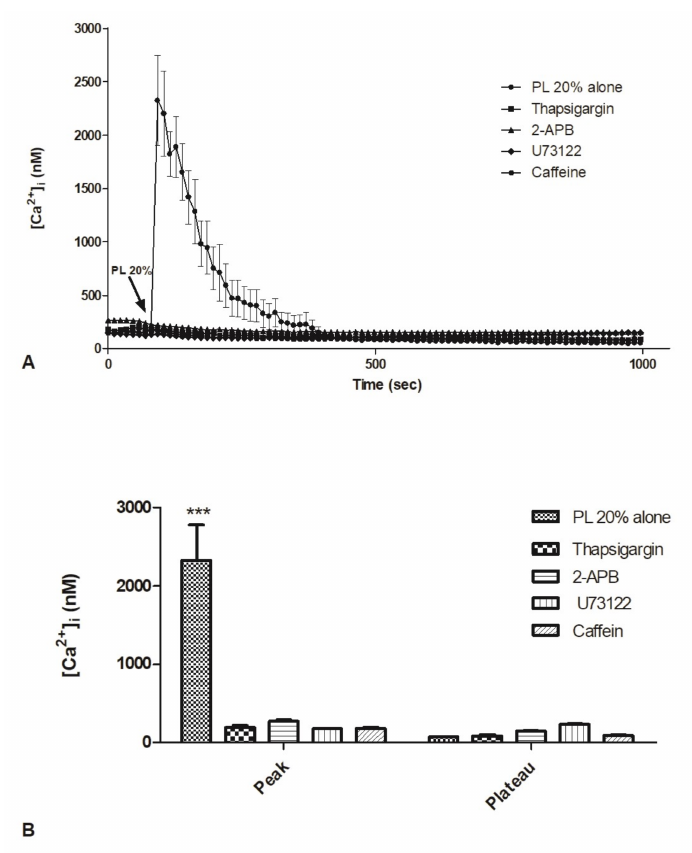
Figure 6. Contribution of intracellular stores to cytosolic Ca 2 + increase. A . PL-induced Ca 2 + release was dramatically reduced in the presence of thapsigargin, 2-APB, U73122, ca ff eine (30 min pre-incubation for each drug). PL was added at 20%. Data are means ± s.e.m. of [Ca 2 + ]i traces recorded in di ff erent cells. Number of cells: PL 20% alone: 20 cells from 3 experiments; PL 20% + thapsigargin 5 µ M: 40 cells from 3 experiments; PL 20% + 2-APB 50 µ M: 45 cells from 3 experiments; PL 20% + U73122 10 µ M: 50 cells from 3 experiments; PL 20% + ca ff eine 10 mM. B . Mean ± s.e.m. of the Ca 2 + response to 20% PL recorded at the peak and at the plateau under the designated treatments. Data are means ± s.e.m. of [Ca 2 + ] i measured by confocal imaging at peak maxima. Number of cells: PL 20% alone: 20 cells from 3 experiments; PL 20% + thapsigargin 5 µ M: 40 cells from 3 experiments; PL 20% + 2-APB 50 µ M: 45 cells from 3 experiments; PL 20% + U73122 10 µ M: 50 cells from 3 experiments; PL 20% + ca ff eine 10 mM. Asterisks on bars indicate statistical di ff erences determined by two-way ANOVA with Bonferroni’s correction ( p <